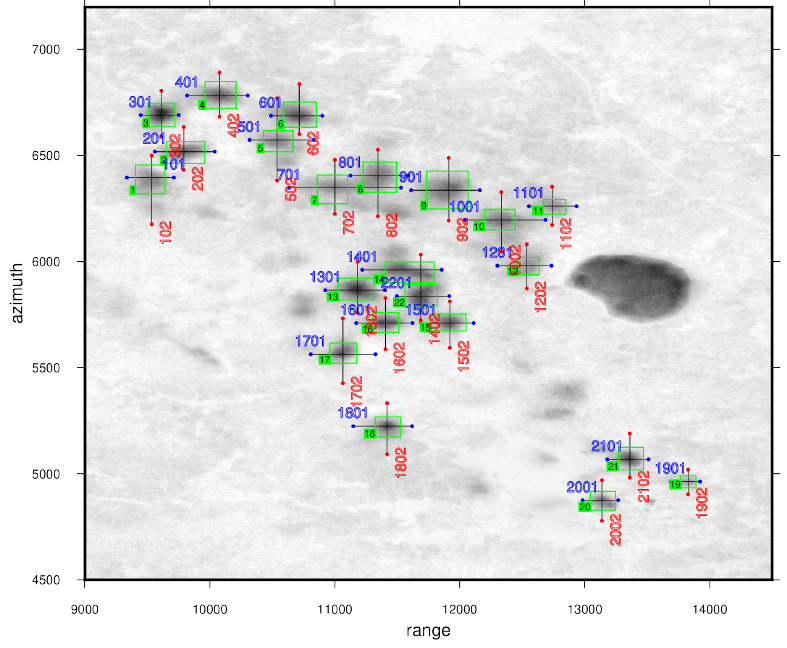
Figure 2. Locations of profiles for the identified subsidence troughs (indicated in green). The results are presented in the satellite system (range/azimuth). The range profiles are indicated in blue, and the azimuth profiles are indicated in